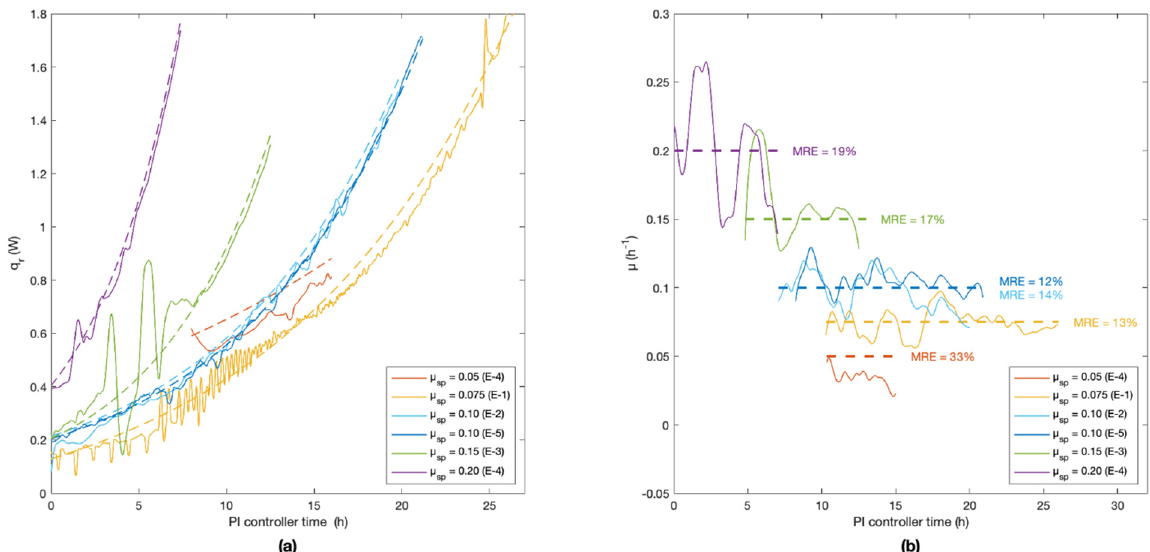
Figure 8. ( a ) Summary of time profiles of the heat generated by cells (q r , solid lines) and the setpoint value (q r,sp , dashed lines) from the controller start (t = 0); ( b ) resulting specific growth rate control during experiments, monitored by dielectric spectroscopy.